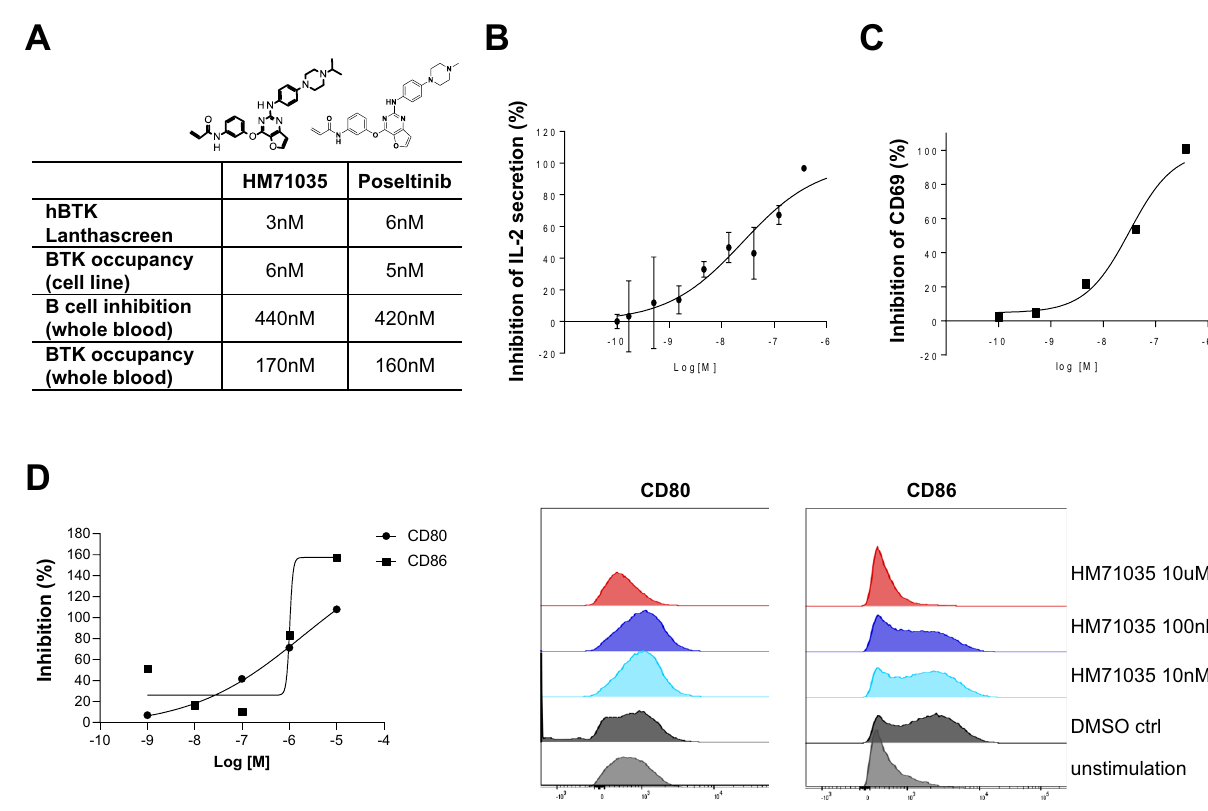
Figure 3. Effects of HM71035 on B cell antigen-presentation function. ( A ) Biochemical activity on hBTK, B cell inhibitory efficacy, and BTK occupancy in B cell line or whole blood of HM71035 and poseltinib. ( B ) B cells that were preactivated in vivo were isolated and incubated with HM71035 for 1 h before being used as antigen-presenting cells to OVA-323–339-specific transgenic T cells. Activation of T cells was inferred from IL-2 production and ( C ) CD69 upregulation, which were inhibited by HM71035. ( D ) Expression levels of the costimulatory markers CD80 and CD86 on B cells were inhibited by HM71035 in a dose-dependent